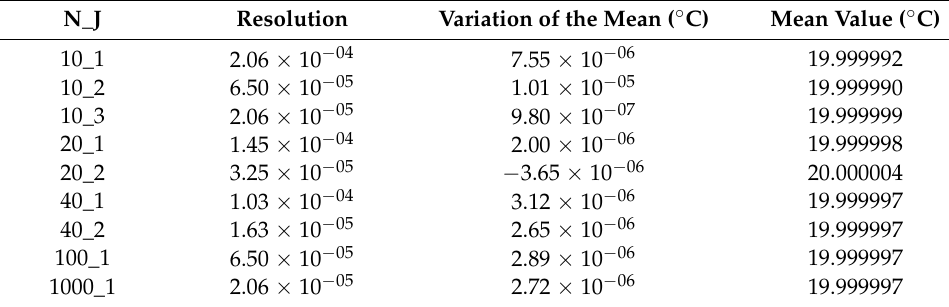
Table 3. Mean and Variance of the Mean Relative to 20.000000 ◦